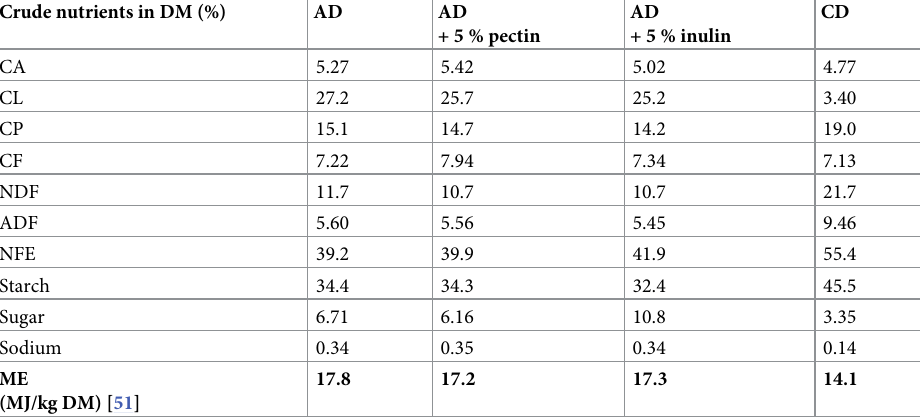
The data are presented as percentages of DM. DM, dry matter; AD, atherogenic diet; CD, conventional diet; CA, crude ash; CL, crude lipid; CP, crude protein; CF, crude fiber; NDF, ash-free neutral detergent fiber; ADF, ash-free acid detergent fiber; NFE, nitrogen-free extracts; ME, metabolizable